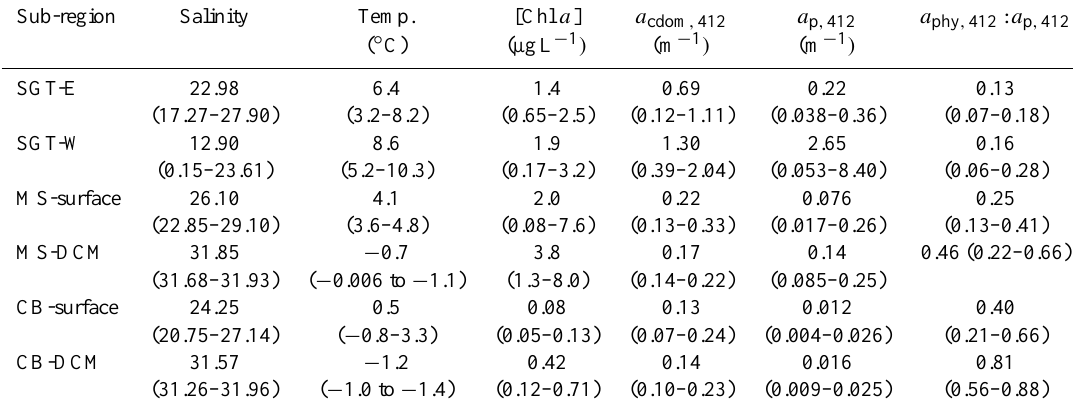
Table 2. Means and ranges (in the parentheses) of salinity, temperature, [Chl a ], a cdom , 412 , a p , 412 , and a phy , 412 : a p , 412 . Keys in the sub-region column are the same as those in Table